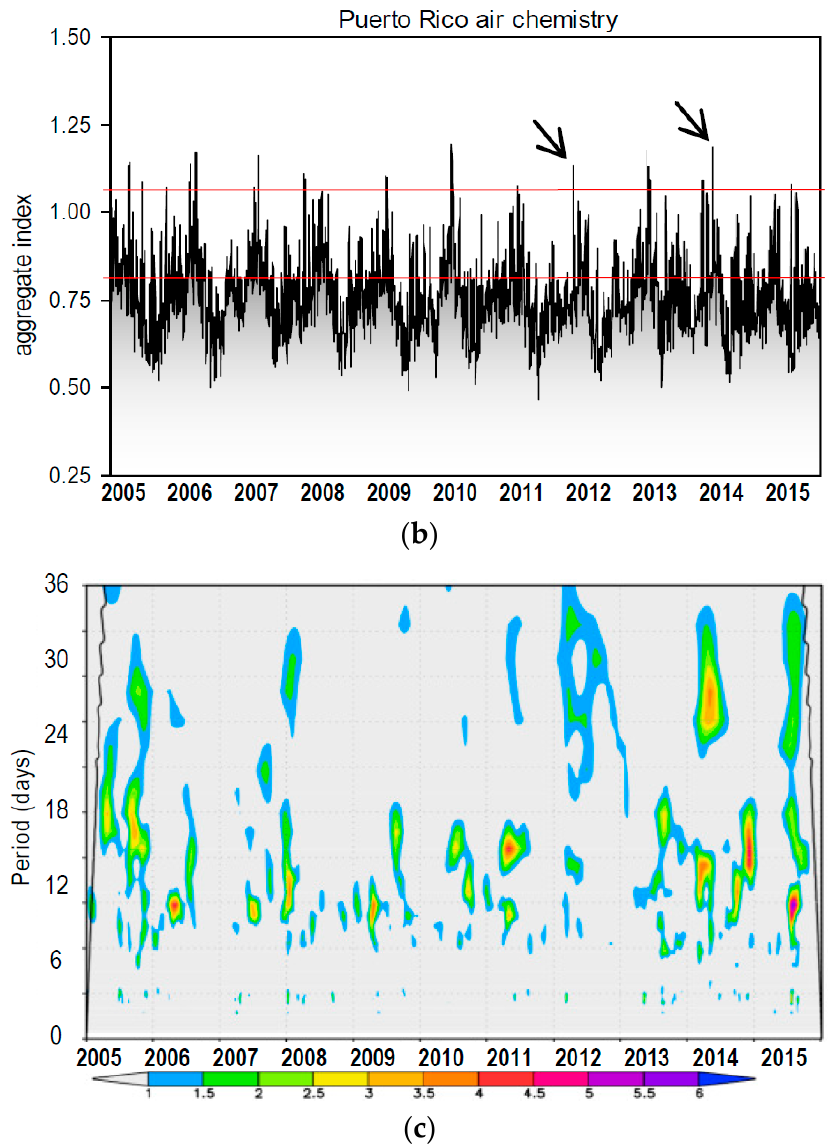
Figure 5. ( a ) Scatterplots of daily air constituents and weather variables with regression fit, cf. Table 3; ( b ) Daily time series of Puerto Rico air index with case studies (arrows) and thresholds (red lines); ( c ) Wavelet spectral analysis of air index shaded >90% confidence.